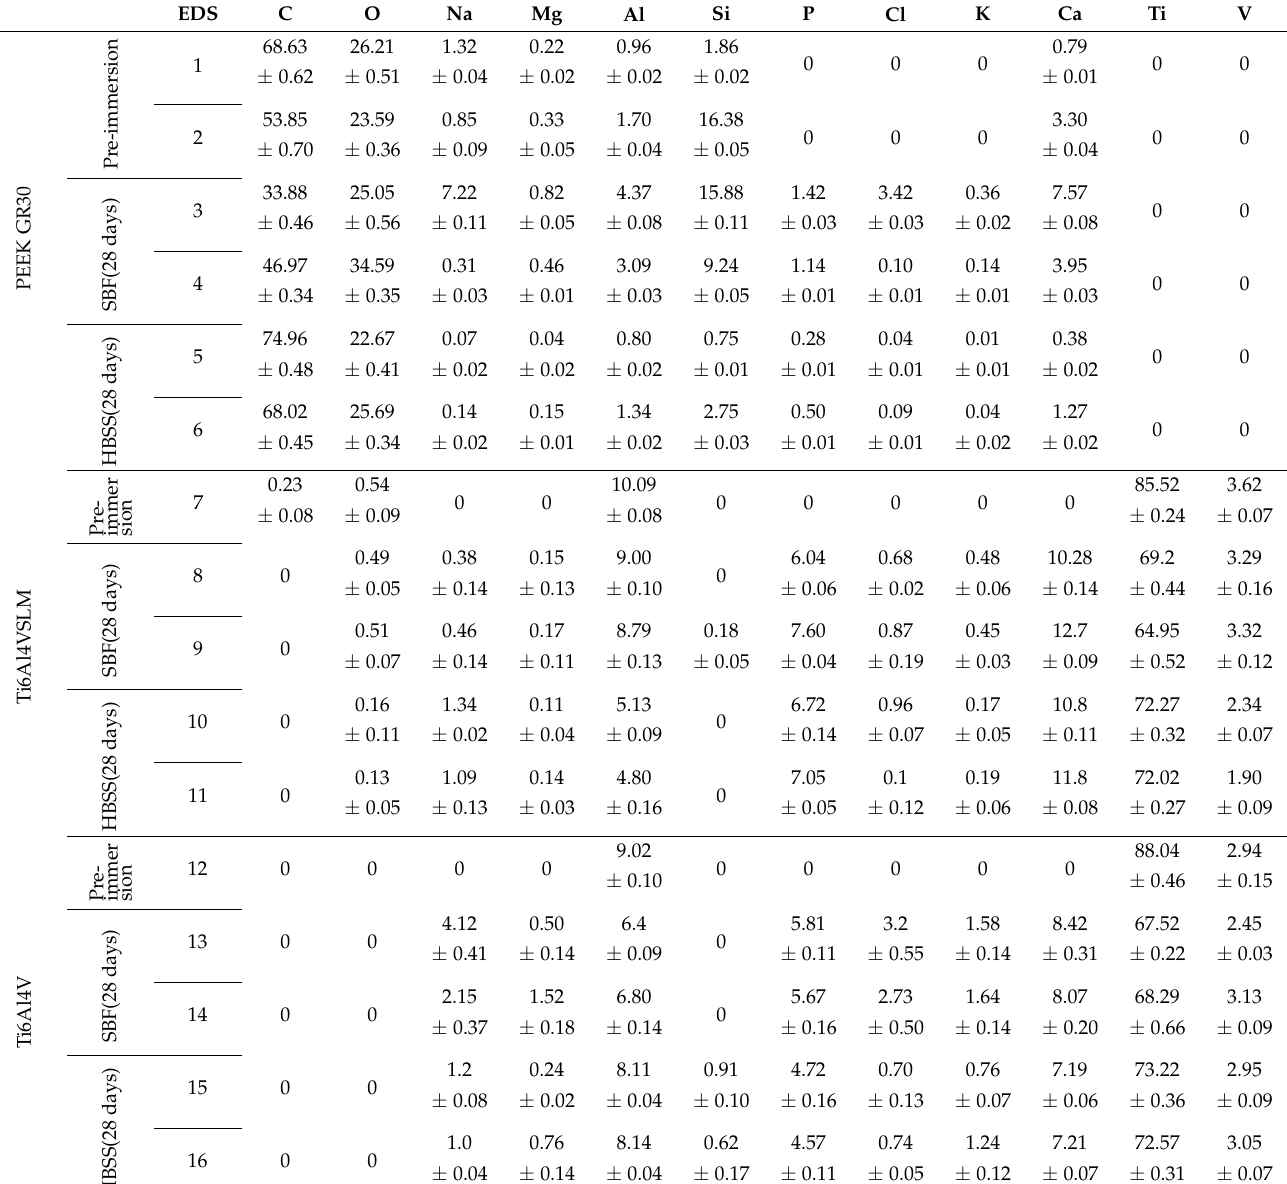
Table 2. Atomic percentage of individual elements before and after 28 days of material immersion in SBF and